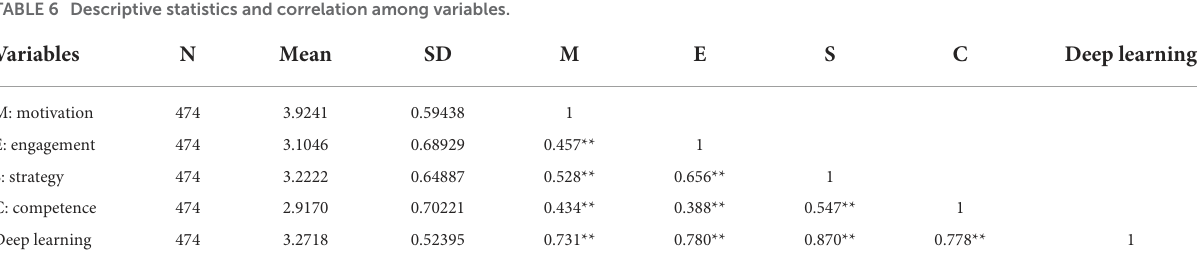
TABLE 6 Descriptive statistics and correlation among